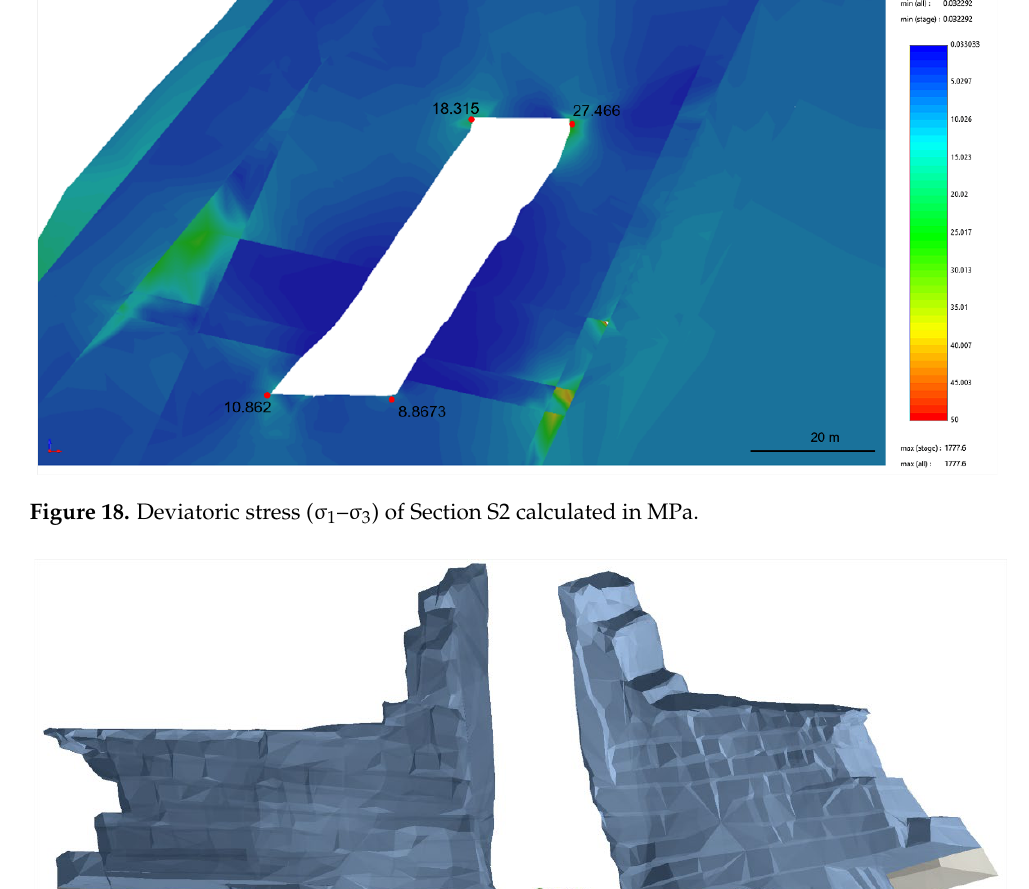
Figure 19. 3D model of the quarry inner part (blue) with the simulation of the excavation advance- ment (grey). Perspective views; the scale bar is indicative only.